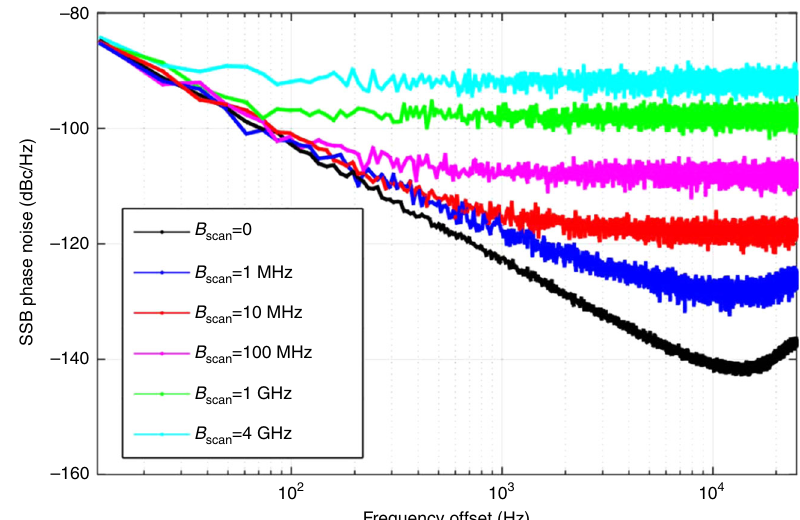
Fig. 6 Simulated phase noise performance with different scanning bandwidth. B scan = 0 corresponds to a conventional single mode